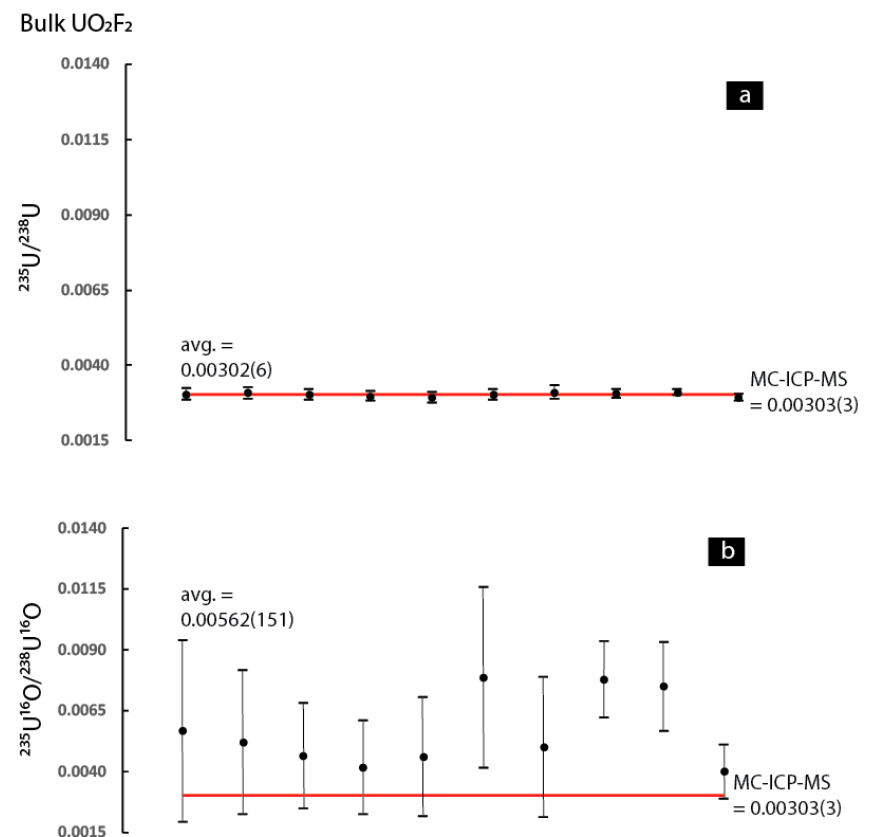
Figure 5. Plot of each analysis’s ( a ) 235 U / 238 U and ( b ) 235 U 16 O / 238 U 16 O ratio and its associated 1 σ uncertainty relative to the solution MC-ICP-MS values (red line) for the UO 2 F 2 .